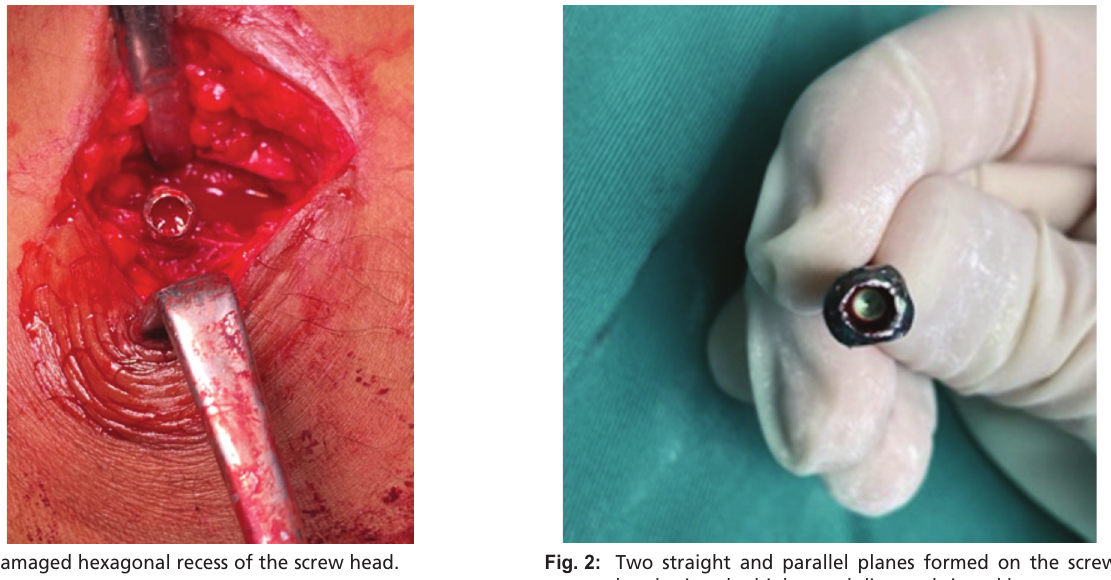
Damaged hexagonal recess of the screw head. Fig. 1: